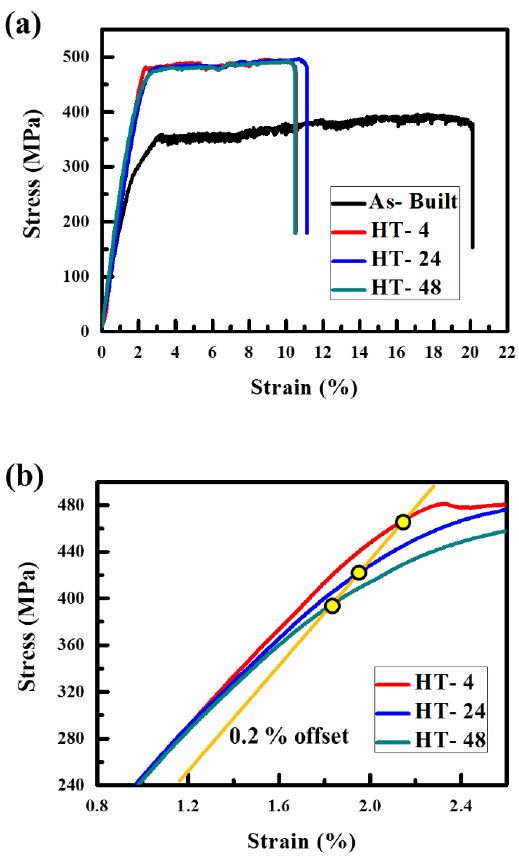
Figure 8. ( a ) Tensile stress–strain curves of the as-built and heat-treated 3D-printed Scalmalloy samples, and ( b ) the enlarged image shows the difference in yield stress of heat-treated samples. Table 4. Summary of tension mechanical properties of the 3D-printed Scalmalloy samples with different processing